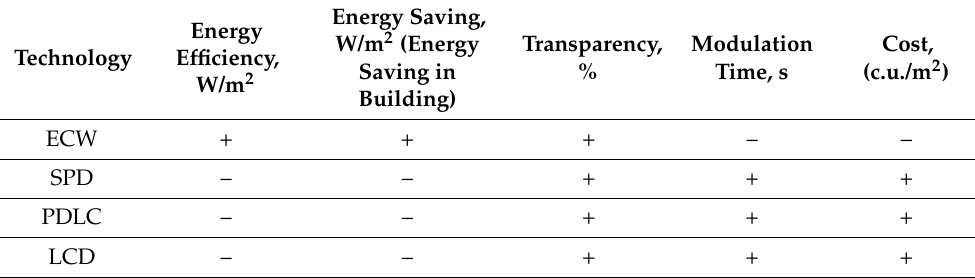
Figure 3. “Smart Window” electrochromic technology: ( a ) sandwich structure and operating principle (bleached state): transmitted and reflected light modulation: 1—electrochromic layer; 2—ion storage layer; 3—glass; 4—conductive layer; 5—ion conductor/electrolyte; ( b ) total view. Table 1. Comparison of “Smart Window”